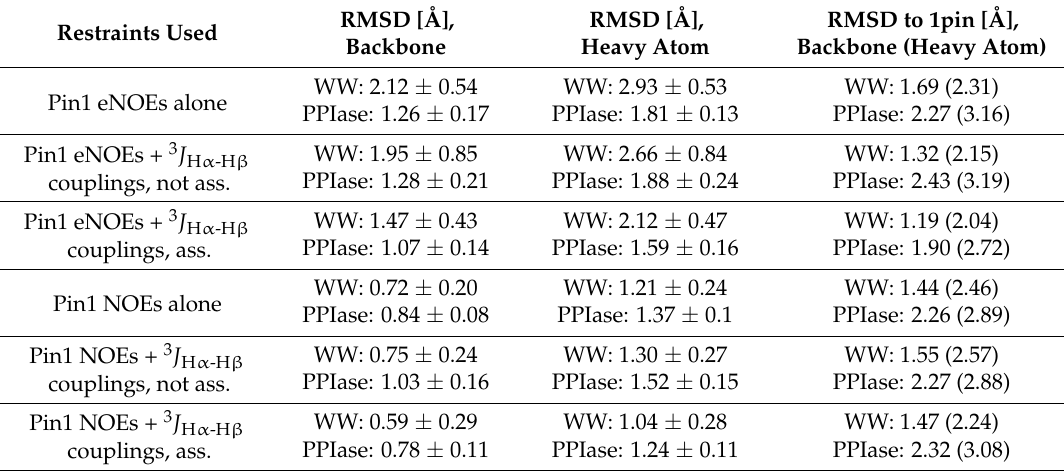
Table 2. Root-mean-square deviations (RMSDs) for various structure calculations for the ensemble compared with its average, as well as with the crystal structure (PDB code 1pin) [16]. RMSD [Å], RMSD [Å], RMSD to 1pin [Å], Restraints Used Backbone Heavy Atom Backbone (Heavy Atom) WW: 2.12 ± 0.54 WW: 2.93 ± 0.53 WW: 1.69 (2.31) Pin1 eNOEs alone PPIase: 1.26 ± 0.17 PPIase: 1.81 ± 0.13 PPIase: 2.27 (3.16)